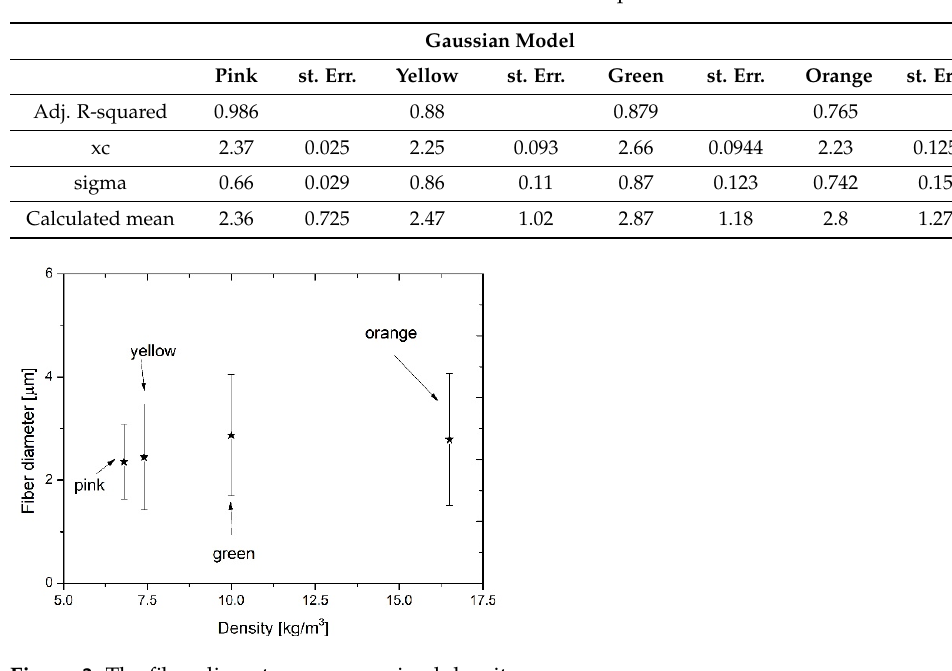
Table 2. The results of the fitted Gaussian model on each sample.